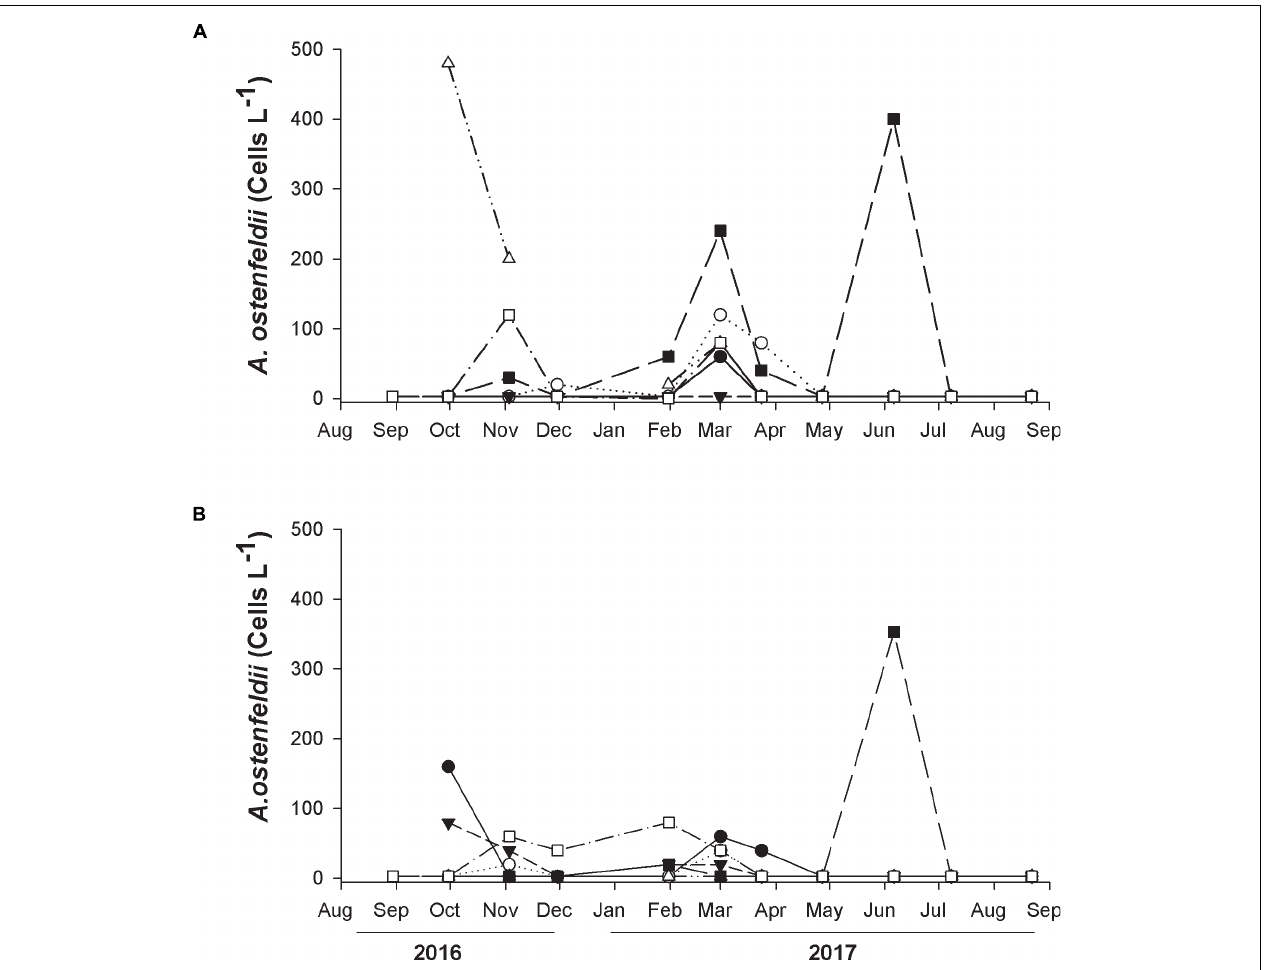
FIGURE 2 | Temporal variation of cell abundance of A. ostenfeldii at seven sampling stations located in Todos Santos Bay region: Station 1 (closed circles), Station 3 (open circles), Station 4 (closed triangles), Station 6 (open triangles), Station 11 (closed square), and Station 12 (open square). Samples were collected at surface (A) and at the thermocline (B) from August 2016 to August